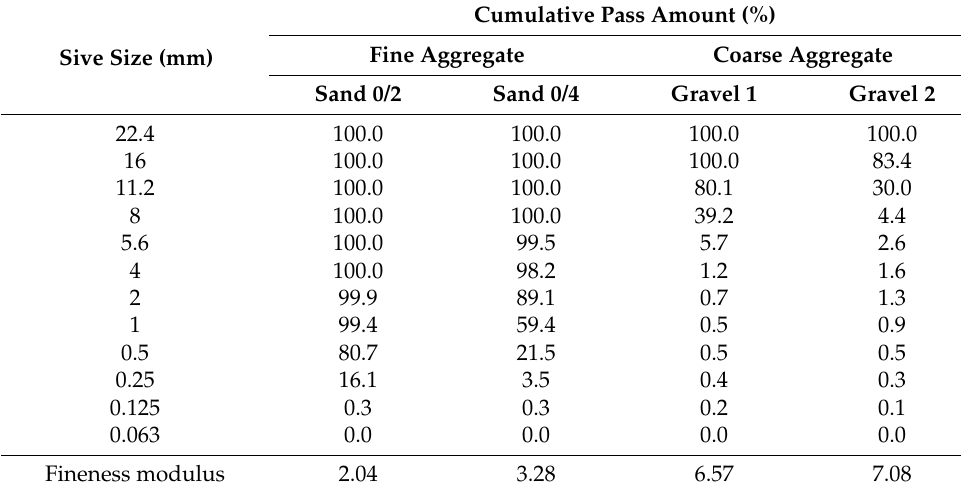
Table 3. Particle size distribution of natural aggregates.